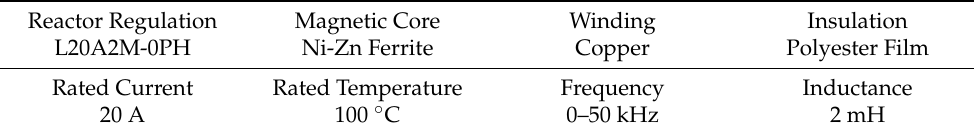
Figure 4. ( a ) Reactor to be tested; ( b ) Reactor core size. Table 1. Reactor parameters